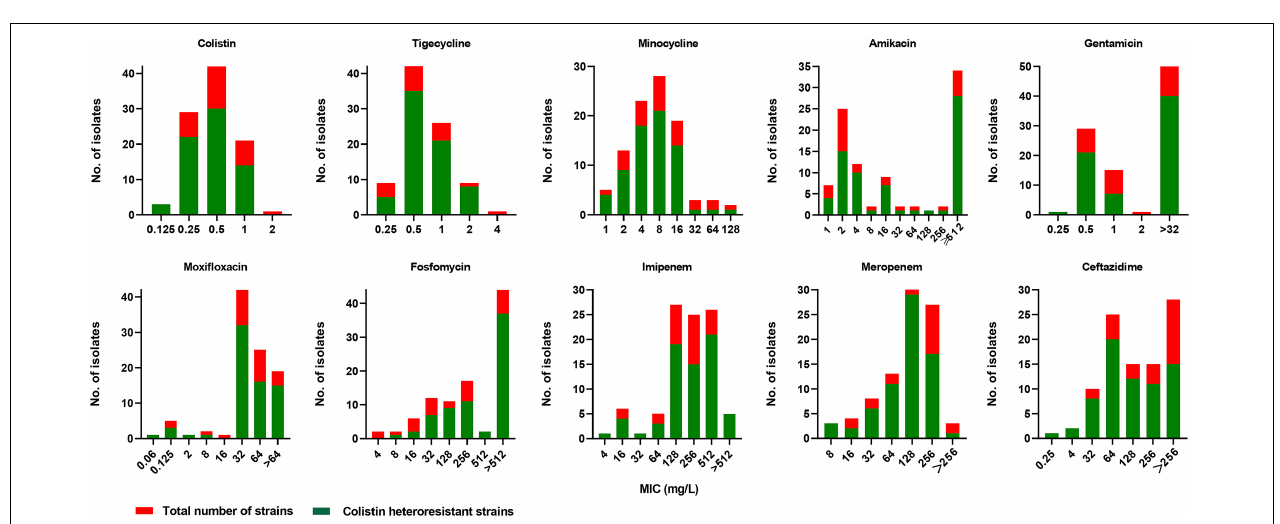
FIGURE 2 | Distribution of colistin heteroresistance at different MICs of colistin, tigecycline, minocycline, amikacin, gentamicin, moxifloxacin, fosfomycin, imipenem, meropenem, and ceftazidime.